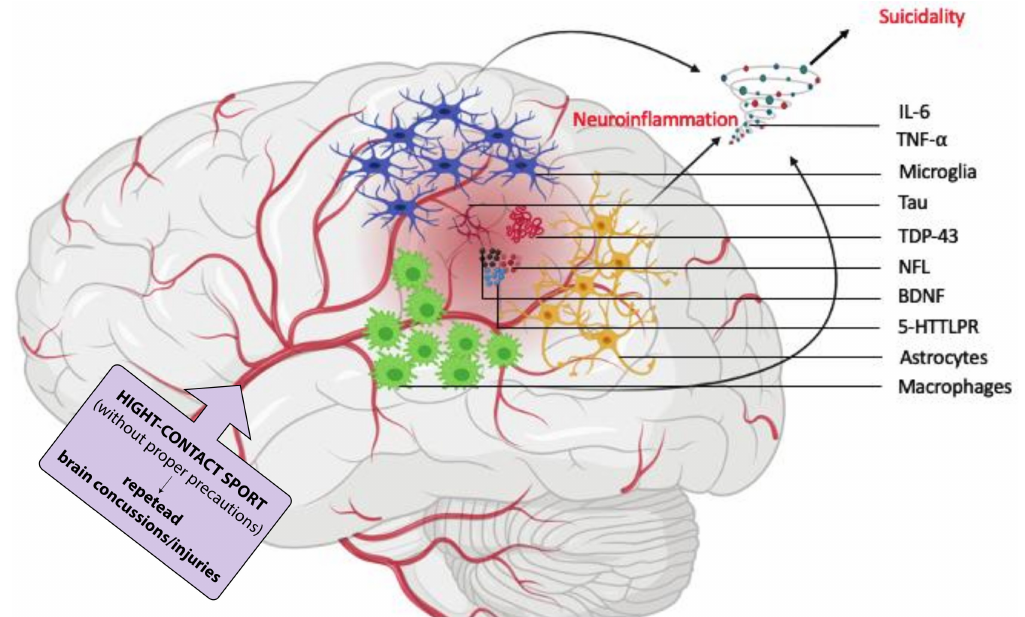
Figure 3. Putative neurobiological mechanism of suicidality development in chronic traumatic encephalopathy (CTE). Chronic progressive head traumas cause axonal damage resulting in pathogenic expression of tau and TAR DNA binding protein 43 (TDP43) proteins and induction of other factors such as neurofilament light polypeptide (NFL), brain-derived neurotrophic factor (BDNF), and serotonin transporter 5-HTTLPR. Consequently, some of these factors trigger immunoreac- tivity from infiltrated macrophages as well as brain resident microglia and astrocytes. The production of neuroinflammatory cytokines such as interleukin 6 (IL-6) and tumour necrosis factor alpha (TNF- α ) by these cells sustain a neuroinflammatory cascade which potentiates—in synergy with BDNF and 5-HTTLPR—the risk for suicidal ideation and behaviour in